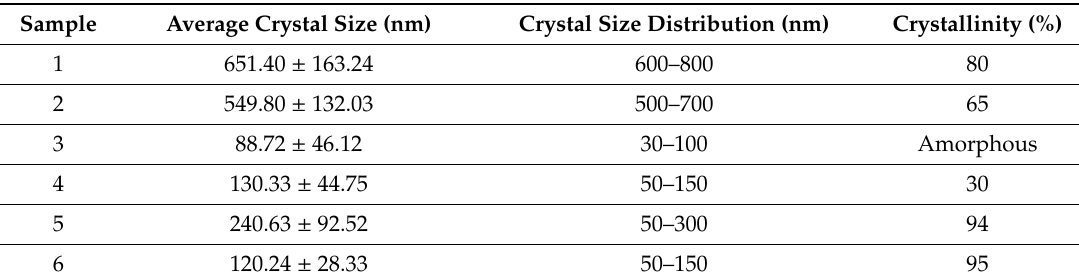
Table 2. Characteristics of NaA samples: average crystal size according to SEM data and crystallinity according to X-ray di ff